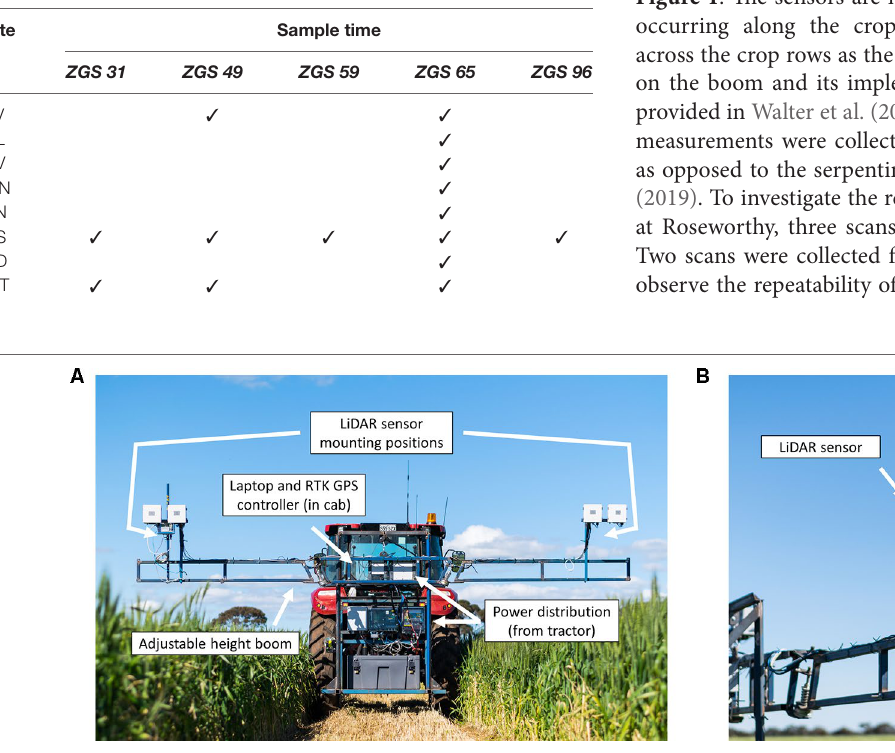
TABLE 2 | Sample times and associated Zadoks growth scale for each of the sites in the current study.